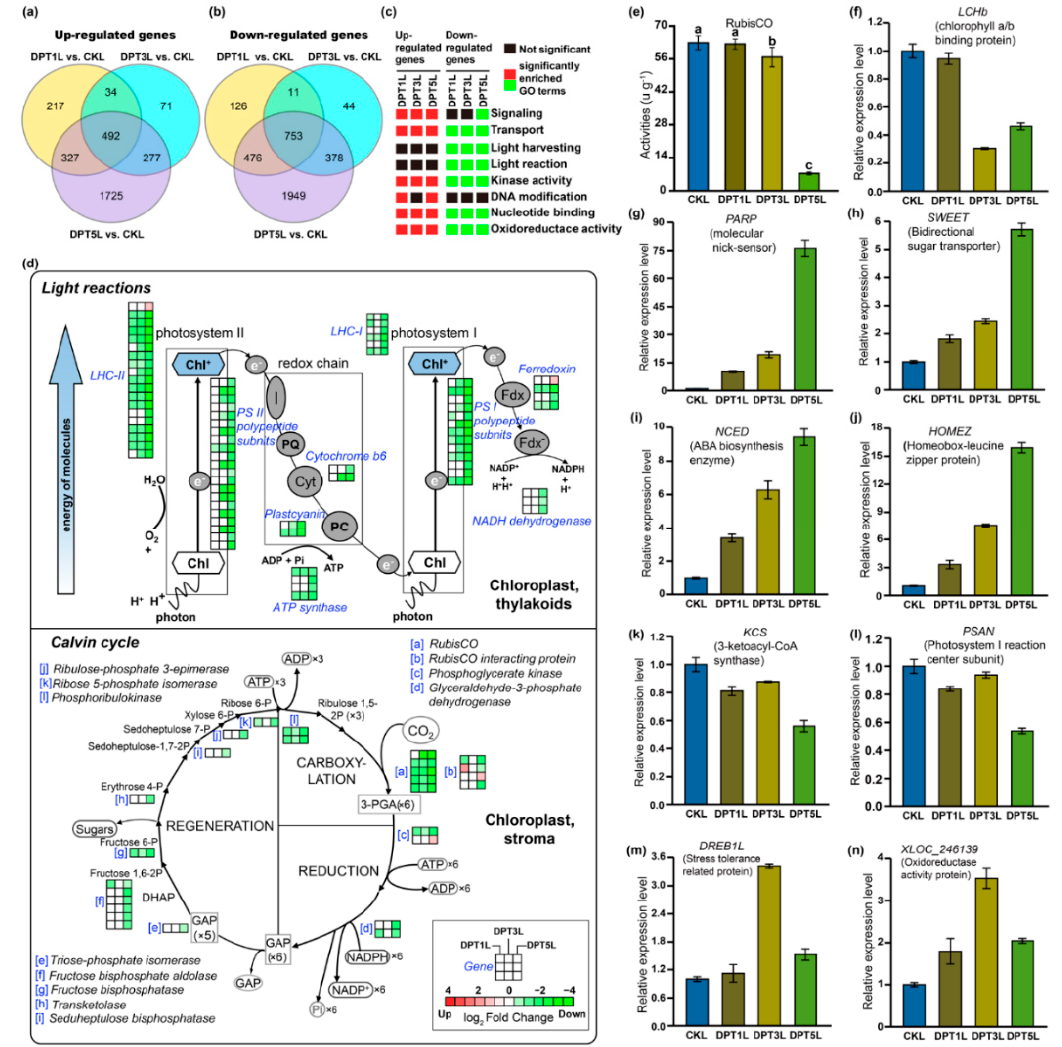
Figure 4. Comprehensive expression patterns of DEGs in the cotyledons of common buckwheat seedlings under drought stress conditions. ( a ) Venn diagrams of the numbers of up-regulated [ | log2 (Fold Change) | > 1 and q-value < 0.005] genes acquired through the transcriptome analysis. ( b ) Venn diagrams of the numbers of down-regulated genes acquired through the transcriptome analysis. ( c ) Over-represented Gene Ontology (GO) terms estimated using GOseq software. ( d ) Changes in the expression of photosynthesis-related genes. Pathway diagram of light and dark reactions of photosynthesis with superimposed color-coded squares showing DEGs, drawn using MapMan. ( e ) Changes in the RubisCO activities of cotyledons. ( f–n ) Expression profiles of the selected DEGs, LCHb ( f ), PARP ( g ), SWEET ( h ), NCED ( i ), HOMEZ ( j ), KCS ( k ), PSAN ( l ), DREB1L ( m ), and XLOC_246139 ( n ) determined using qRT-PCR analyses.